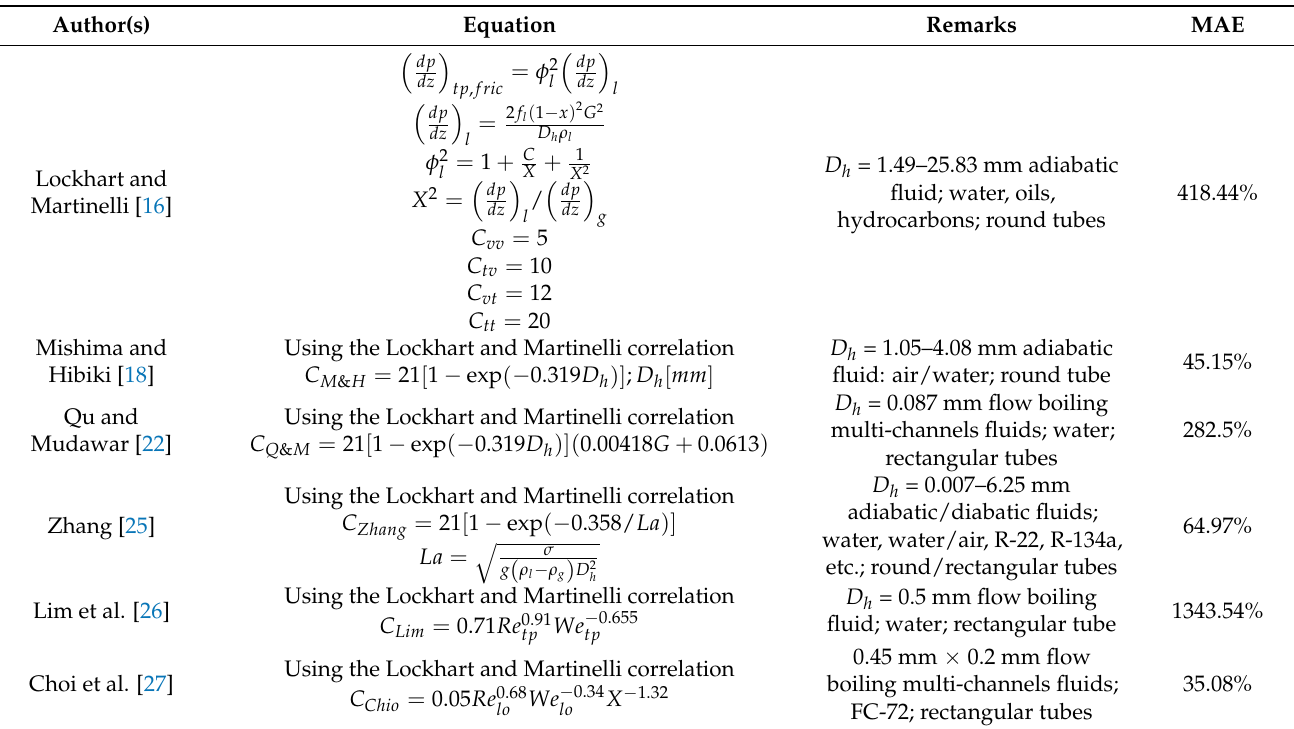
Table 3. Two-phase frictional pressure gradient correlations based on the separated flow model and corresponding MAE in predicting present frictional pressure drop